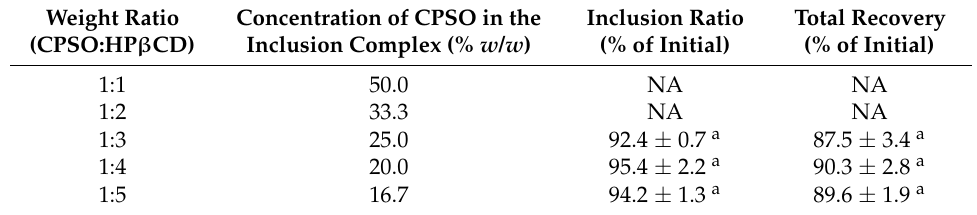
Table 1. The inclusion ratio and total recovery of CPSO-HP β CD inclusion complex at various weight ratios.